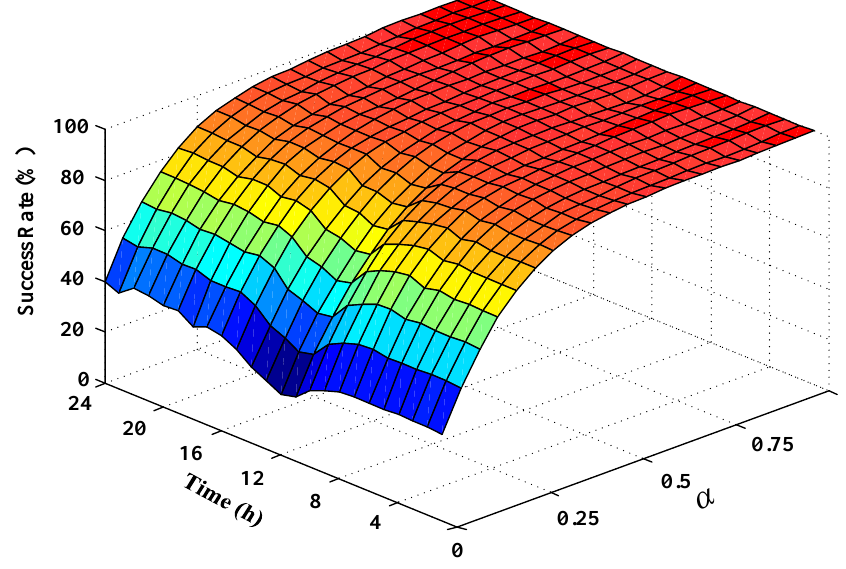
Figure 9. Success rates of system off-grid operation for different α (renewable energy penetration rate is 30%).